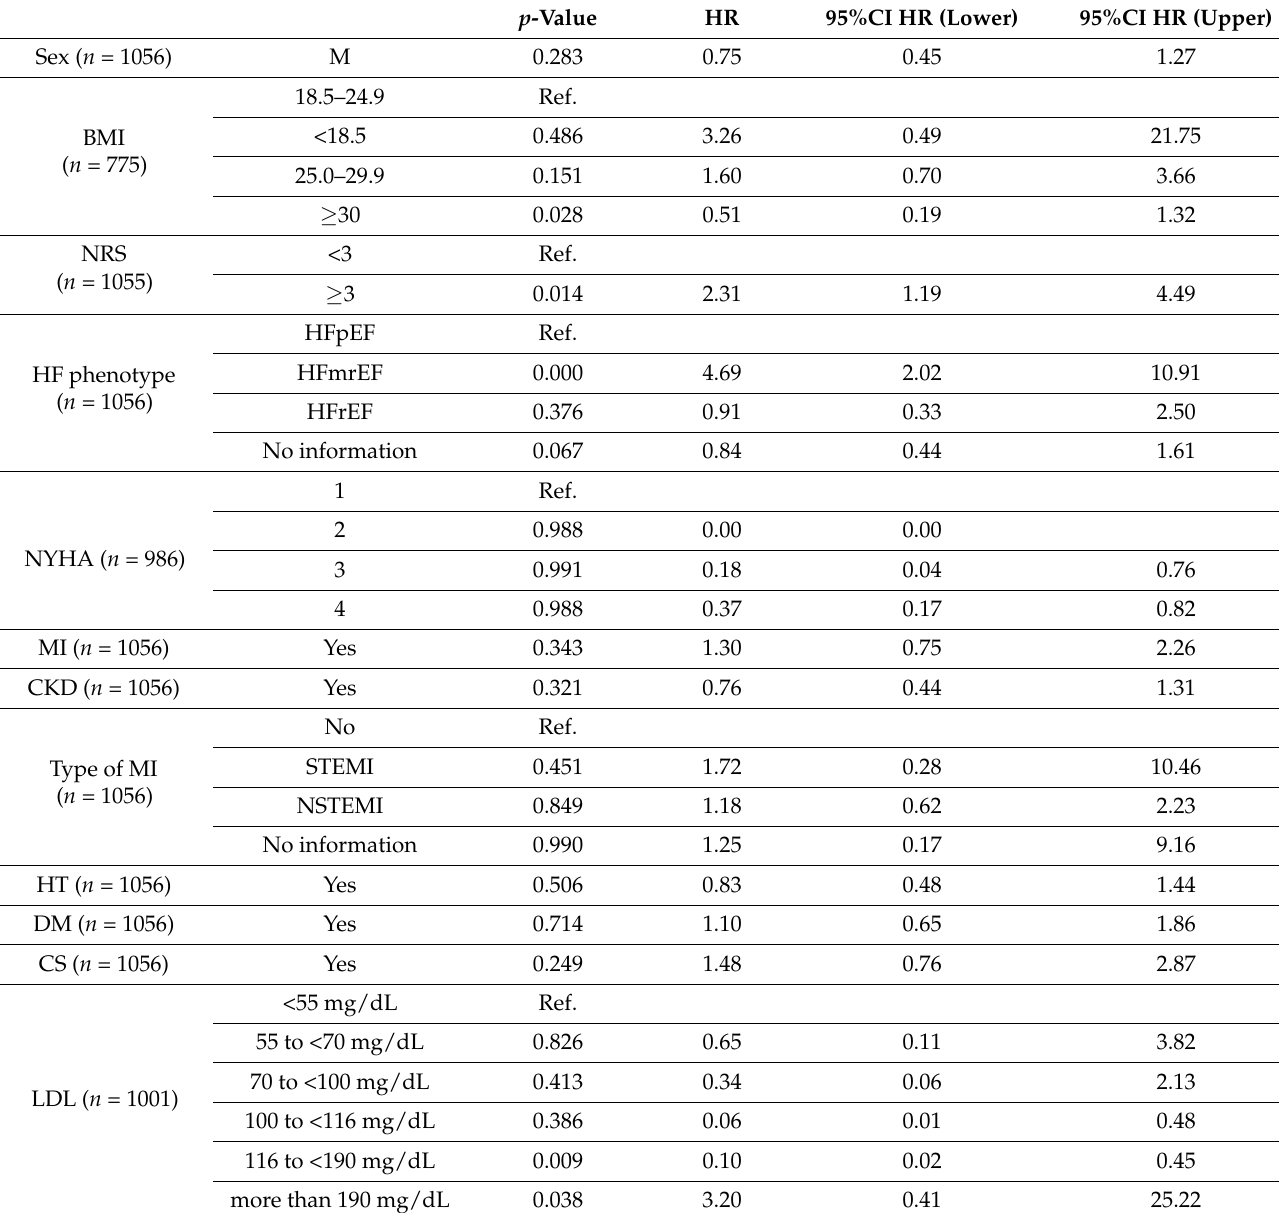
Table 8. The assessment of the influence of variables on mortality—a Cox proportional hazards regression, single model. p -Value HR 95%CI HR (Lower) 95%CI HR (Upper) 0.283